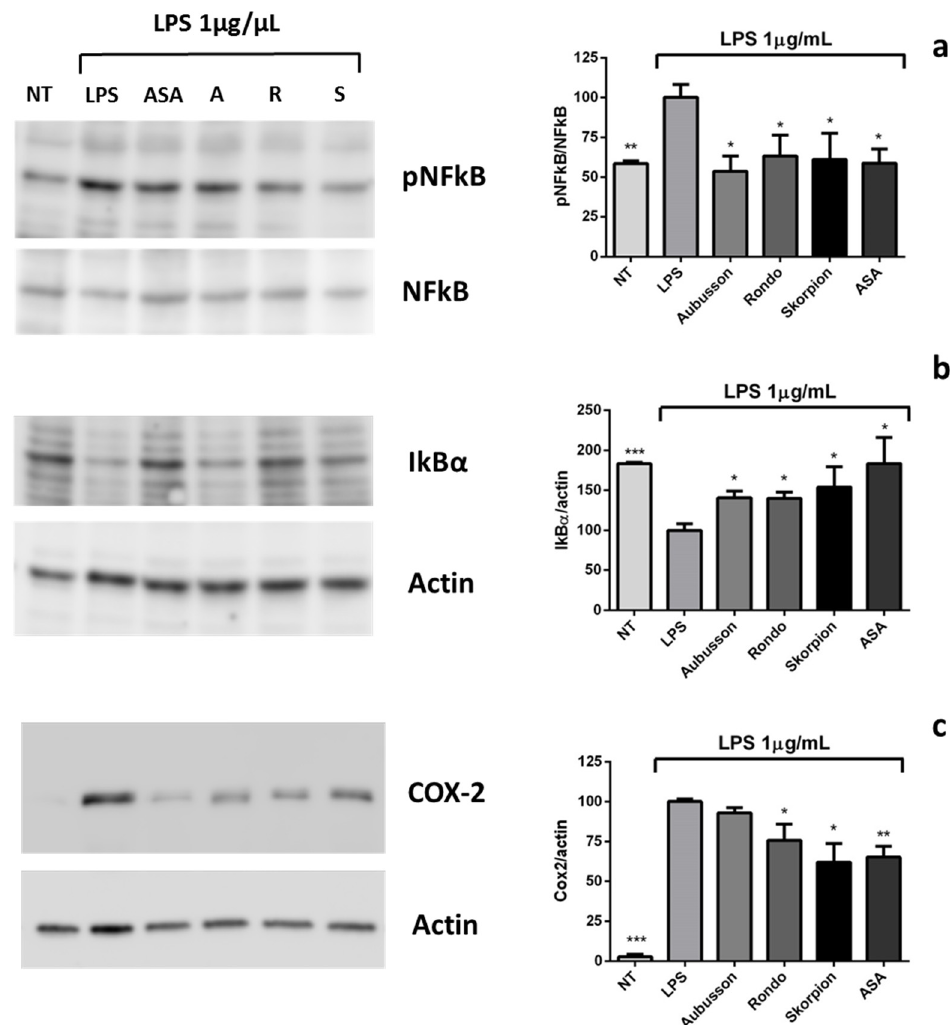
Figure 5. Western blot analysis (on the left) and relative protein levels (on the right) from cells treated with LMW peptides from breads. RAW 264.7 cells were incubated with LMW peptides (0.05 mg/mL) from the breads for 1 h and then with LPS for 24 h. ( a ) The intensity of the signal from anti-phospho-NFkB mAbs was normalized on the anti-total NFkB mAbs signal. ( b ) anti-IkB and ( c ) anti-COX2 mAbs signals were normalized on the actin signal. NT: no treated cells; LPS: cells treated with lipopolysaccharide; ASA: cells treated with LPS and acetyl salicylic acid. Aubusson, Rondo, and Skorpion indicate cells treated with both LPS and LMW peptides. Data reported in the figure represent the mean ( ± SD) of three different experiments performed in duplicate. Statistical analysis was performed for each sample vs. LPS. (* p < 0.05; ** p < 0.01; *** p < 0.001).